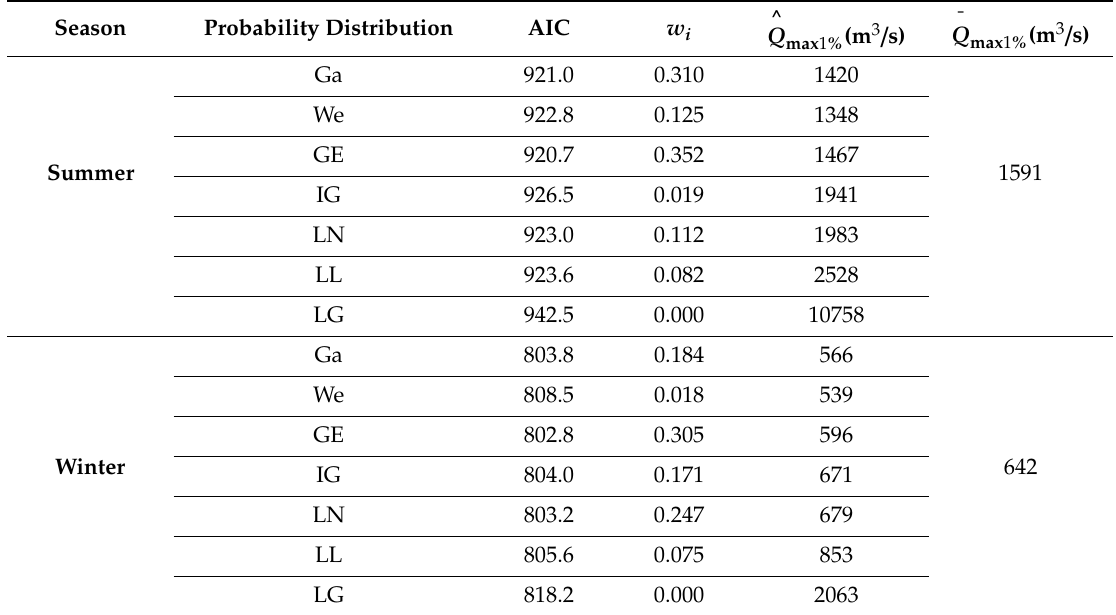
Table 4. Data for the aggregation of the 1% quantile for individual candidate distributions of seasonal maximum flows from 1951–2016 at Prosz ó wki